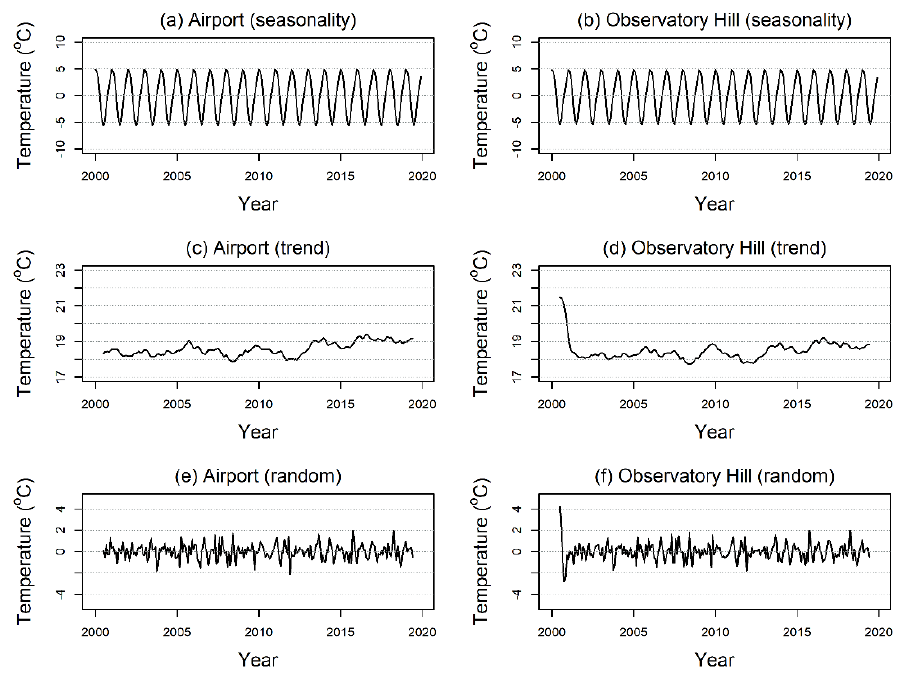
Figure 3. Decomposition of mean monthly temperatures of Sydney airport and Observatory Hill stations, into seasonality ( a , b ), trend ( c , d ) and random ( e , f ).